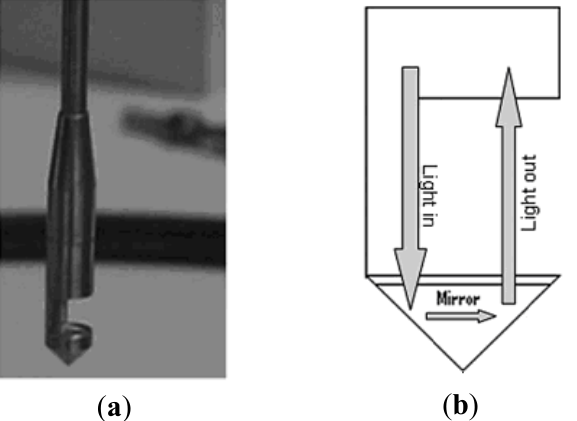
Figure 5. Fiber-optical immersion probes with replaceable tips: ( a ) image of one probe; ( b ) schematic drawing of the UV-VIS light path